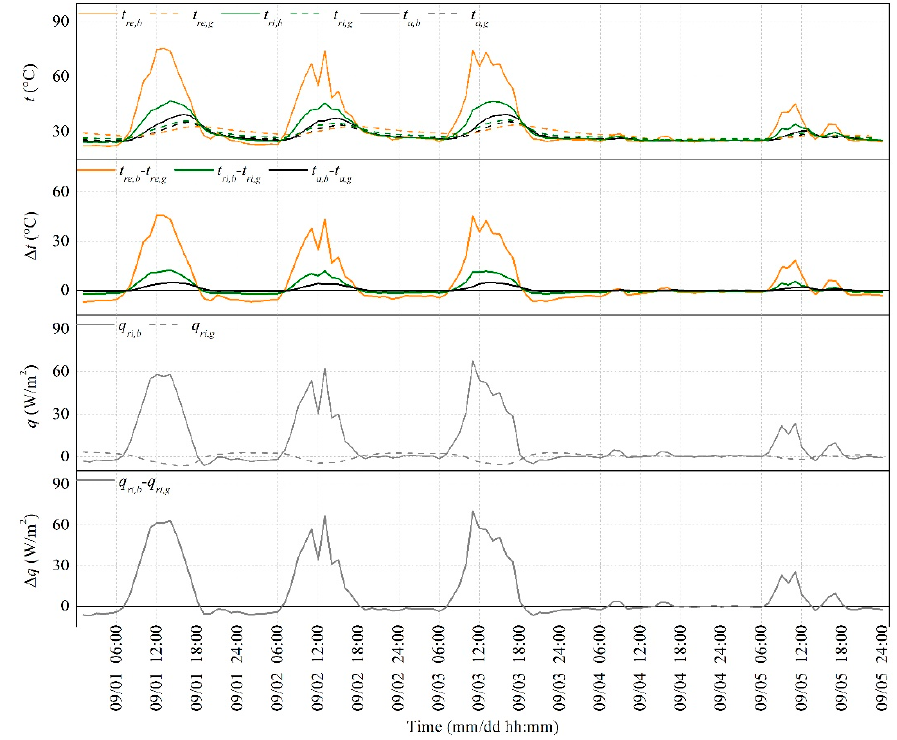
Figure 6. Cooling benefits of the green roof in the non-air-conditioning experimental conditions. t re,b , t ri,b , and t a,b : external surface, internal surface, and chamber air temperature of the bare roof, respectively; t re,g , t ri,g , and t a,g : external surface, internal surface, and chamber air temperature of the green roof, respectively; q ri,b : internal surface heat flux of the bare roof; and q ri,g : internal surface heat flux of the green roof.